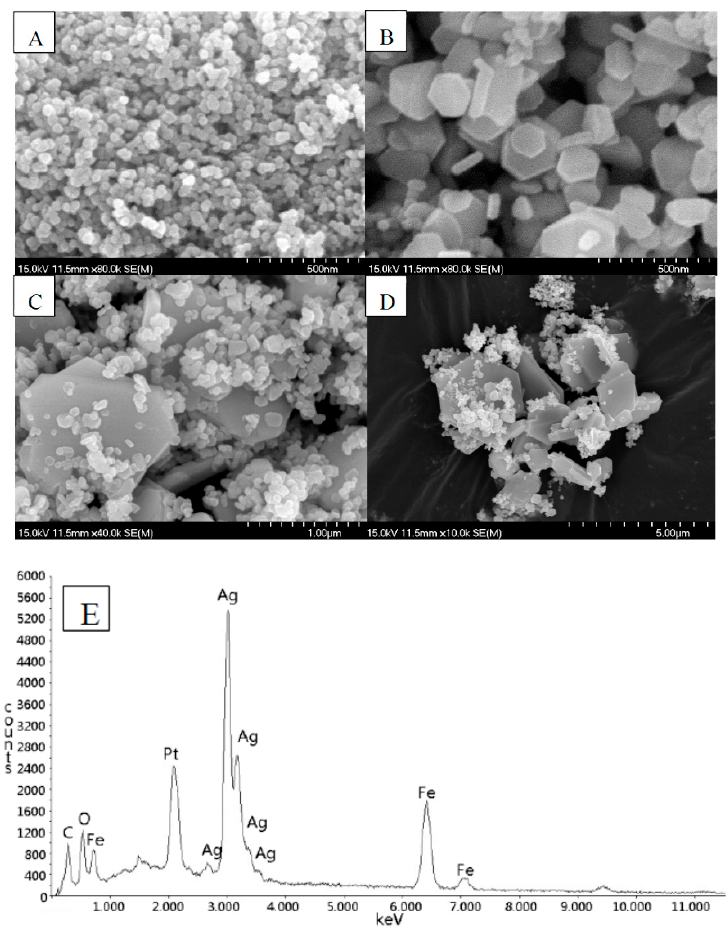
Figure 3. FE ‐ SEM image of AFO ‐ 3 ( A ), AFO ‐ 6 ( B ), AFO ‐ 12 ( C ), AFO ‐ 24 ( D ), and EDS spectrum Figure 3. FE-SEM image of AFO-3 ( A ), AFO-6 ( B ), AFO-12 ( C ), AFO-24 ( D ), and EDS spectrum of of AFO ‐ 6 ( E ). AFO-6 ( E